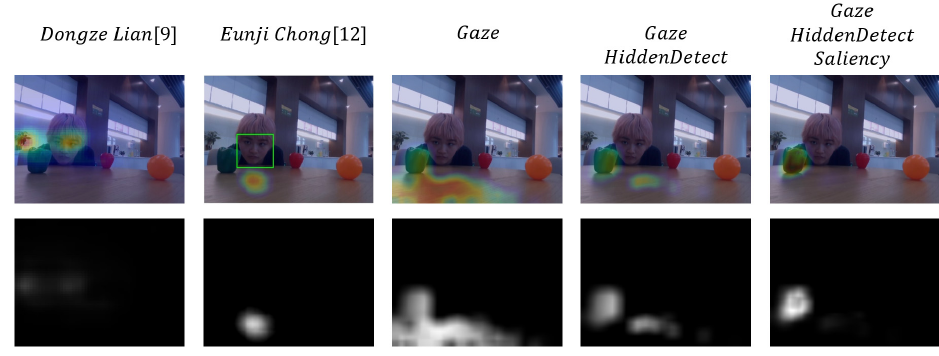
Figure 6. Application of the robot in autism rehabilitation training.